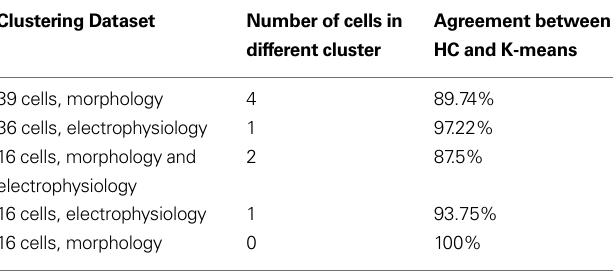
Table 4 | Agreement of hierarchical clustering (HC) using Ward’s method with K-means clustering for K = number of clusters determined signifi cant by HC.